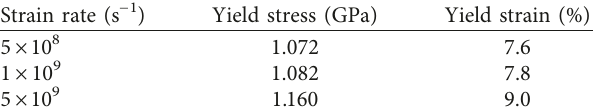
Table 2: The yield stress and strain as a function of strain rate. Strain rate